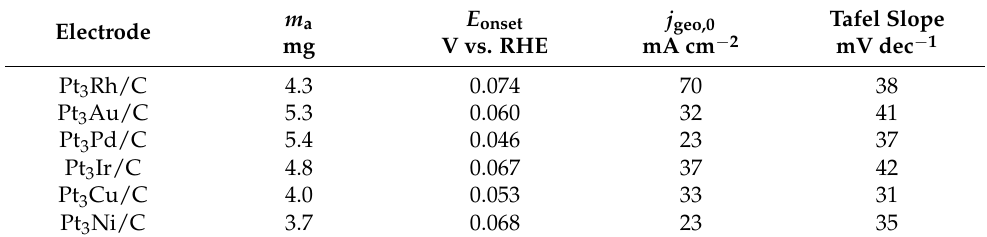
Table 3. m a , E onset , j geo,0 and Tafel slope for the activated Pt 3 M/C (M = Rh, Au, Pd, Ir, Cu and Ni) electrodes.